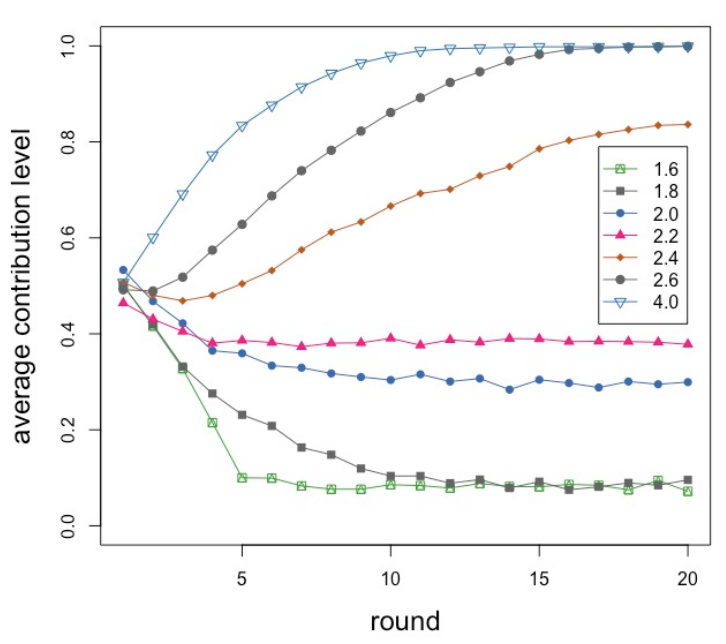
Figure 4. Average contribution from simulation of a small network of 20 agents as a function of the round number for the r values shown in the inset. Averages are taken over 20 independent repetitions of the simulation.